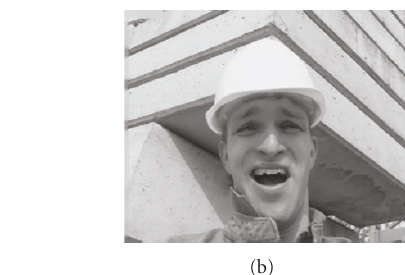
(cid:3)∇ E ( z n ) (cid:3) / (cid:3)∇ E ( z 0 ) (cid:3) against the computational time, and Figure 15(b) is the demonstration of PSNR value versus the computational time. From both the gradient norm and PSNR convergence criteria, the FBIP TV algorithm greatly outperforms the GD TV algorithm and GD BTV